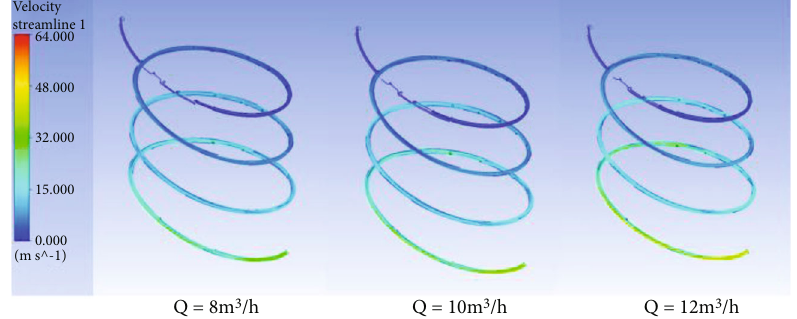
Figure 8: Velocity streamline fi gure of spiral